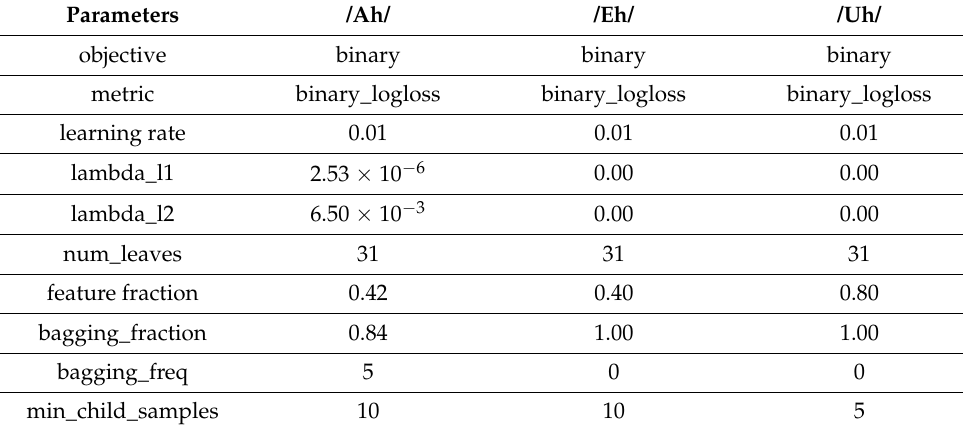
Table 6. Parameter settings for the LightGBM classifiers.